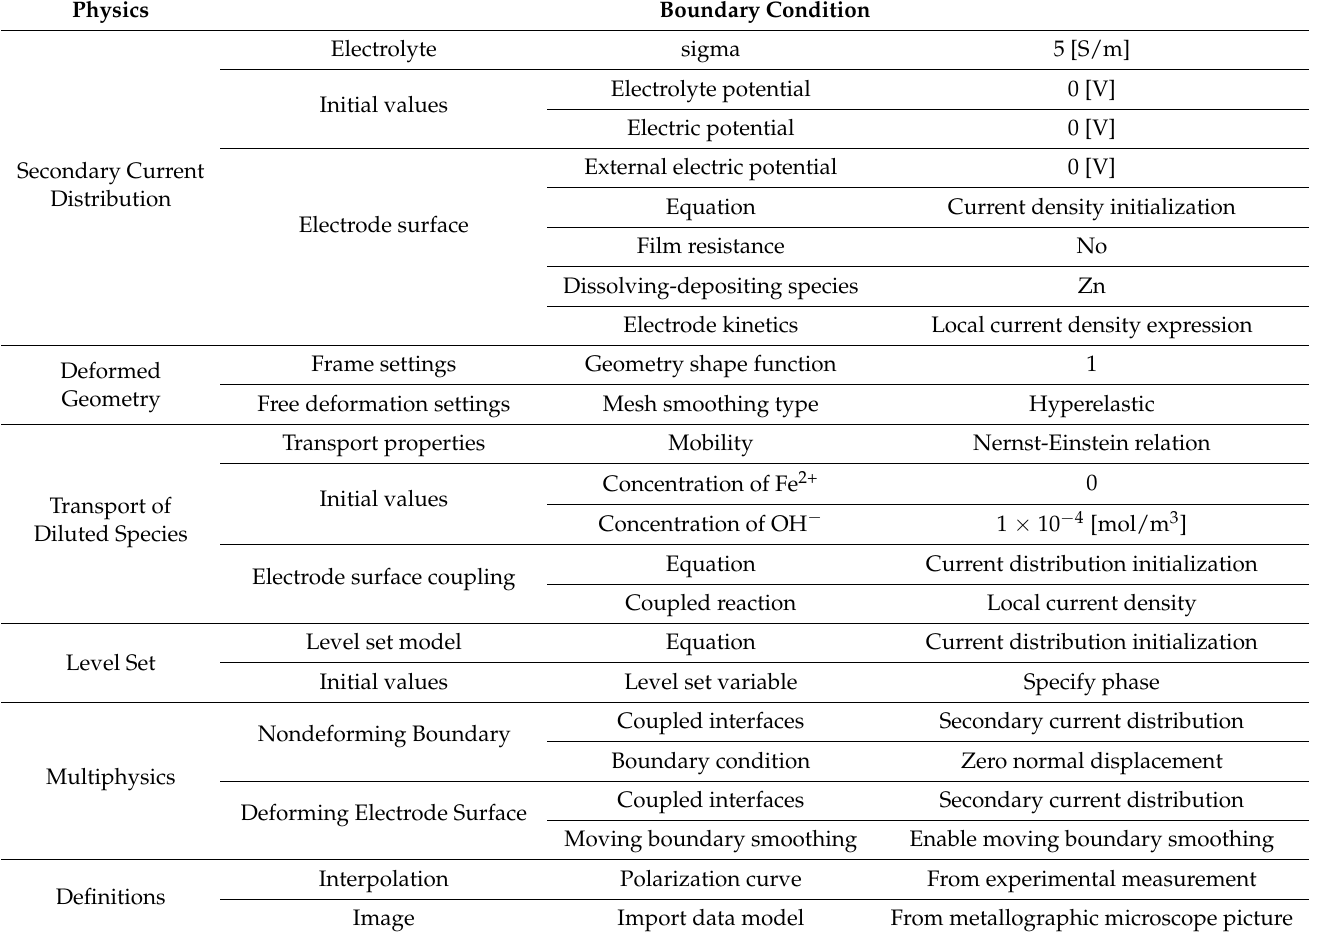
Table 1. The main boundary conditions of COMSOL finite element